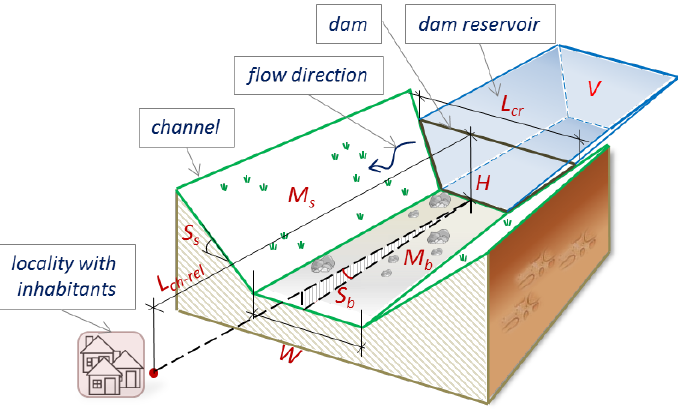
Figure 2. Model input parameters for dam, reservoir, and topography downstream of the dam.